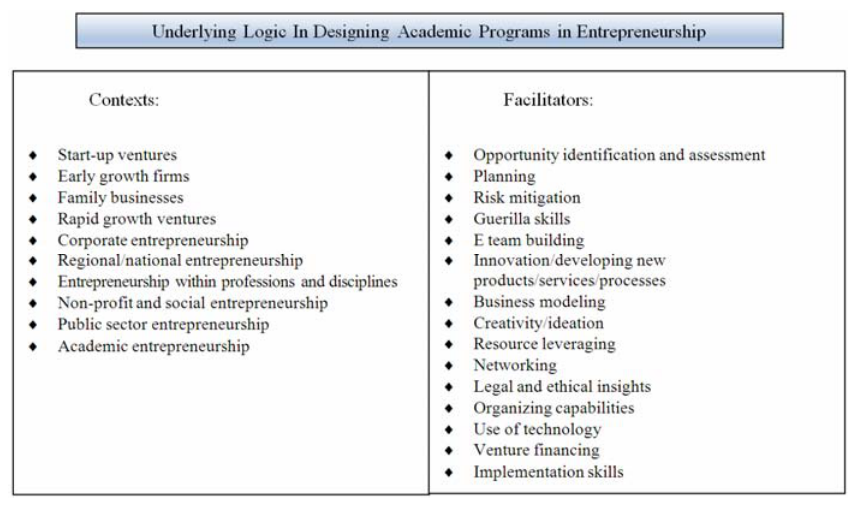
Fig. 1. A model to guide program design in entrepreneurship